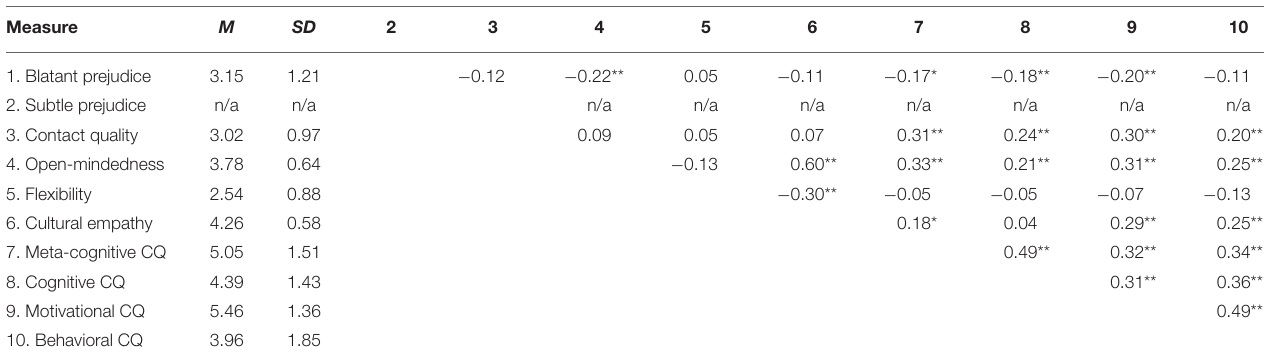
TABLE 4C | Serbian sample: means, standard deviations, and intercorrelations for the main variables.